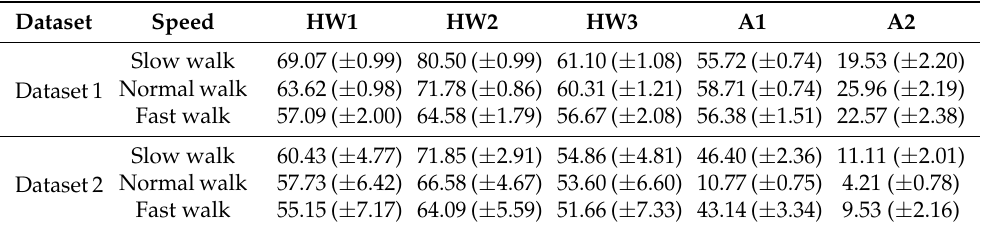
Table 2. Average amplitude (in terms of percentages, %) of the quasi-periodic signals obtained with the five ratio-based body measurements.